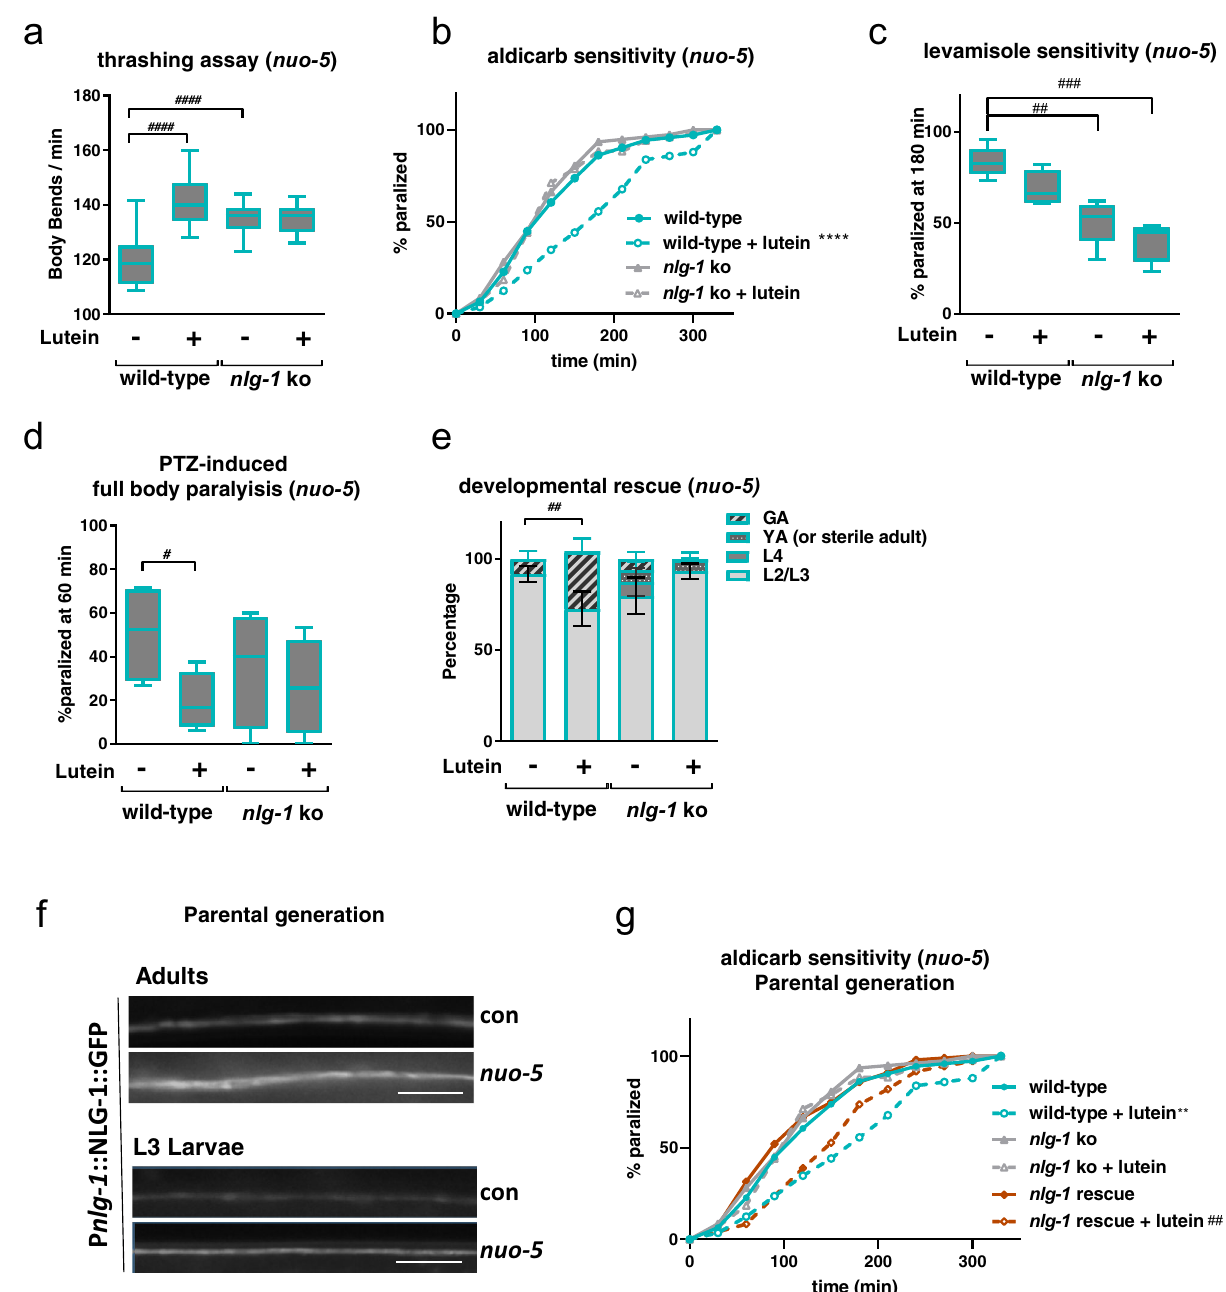
Fig. 8 Neuroligin mediates the protective effect of lutein on cholinergic synapses. a Frequency of body bends in liquid media ( “ thrashing ” ) were quanti fi ed manually for one minute. n ≥ 45 over three biologically independent experiments. p < 0.0001. b Aldicarb-induced paralysis curves on plates containing 0.5 mM aldicarb. Log-rank test: wild-type vs wild-type + lutein p = 4.40 E-07 . n ≥ 89 over three biologically independent experiments. c Percentage of animals paralyzed after 180 min on plates containing 50 µ M Levamisole. Box plots indicate median (middle line), 25th, 75th percentile (box) and 5th and 95th percentile (whiskers) as well as outliers (single points). n = 120 over four biologically independent experiments. wild-type vs nlg-1 ko p = 0.0012, wild-type vs nlg-1 ko + lutein p = 0.0001. d Bars indicate the percentage of animals showing full-body paralysis after one hour of exposure to 2.5 mg/ml PTZ. n = 60 over four biologically independent experiments. wild-type vs wild-type + lutein p = 0.0029. e Bars indicate the percentage of different developmental stages in wild-type and nlg-1 mutants after 6 days from egg lay. Asterisks denote differences between the percentages of animals that reached the gravid adult (GA) stage. n ≥ 120 over four biologically independent experiments, two-way ANOVA, followed by Tukey ’ s multiple- comparisons test. wild-type vs wild-type + lutein p = 0.0049. f Representative pictures of p nlg-1 ::NLG-1::GFP in ventral nerve cord of adult and L3 larvae in the parental generation. Scale bar 10 µ m. Three biologically independent experiments with similar results. g Aldicarb sensitivity assay in the nlg-1(ok259) rescued by a p nlg-1 ::NLG-1 transgene, aldicarb-induced paralysis curves, plates containing 1 mM aldicarb. Log-rank test: wild-type vs wild-type + lutein p = 0.004, nlg-1 rescue vs nlg-1 rescue + lutein p = 0.0064. n ≥ 75 over three biologically independent experiments. The assay was carried out using adult worms of the parental generation. Data for all panels are provided as a Source Data fi